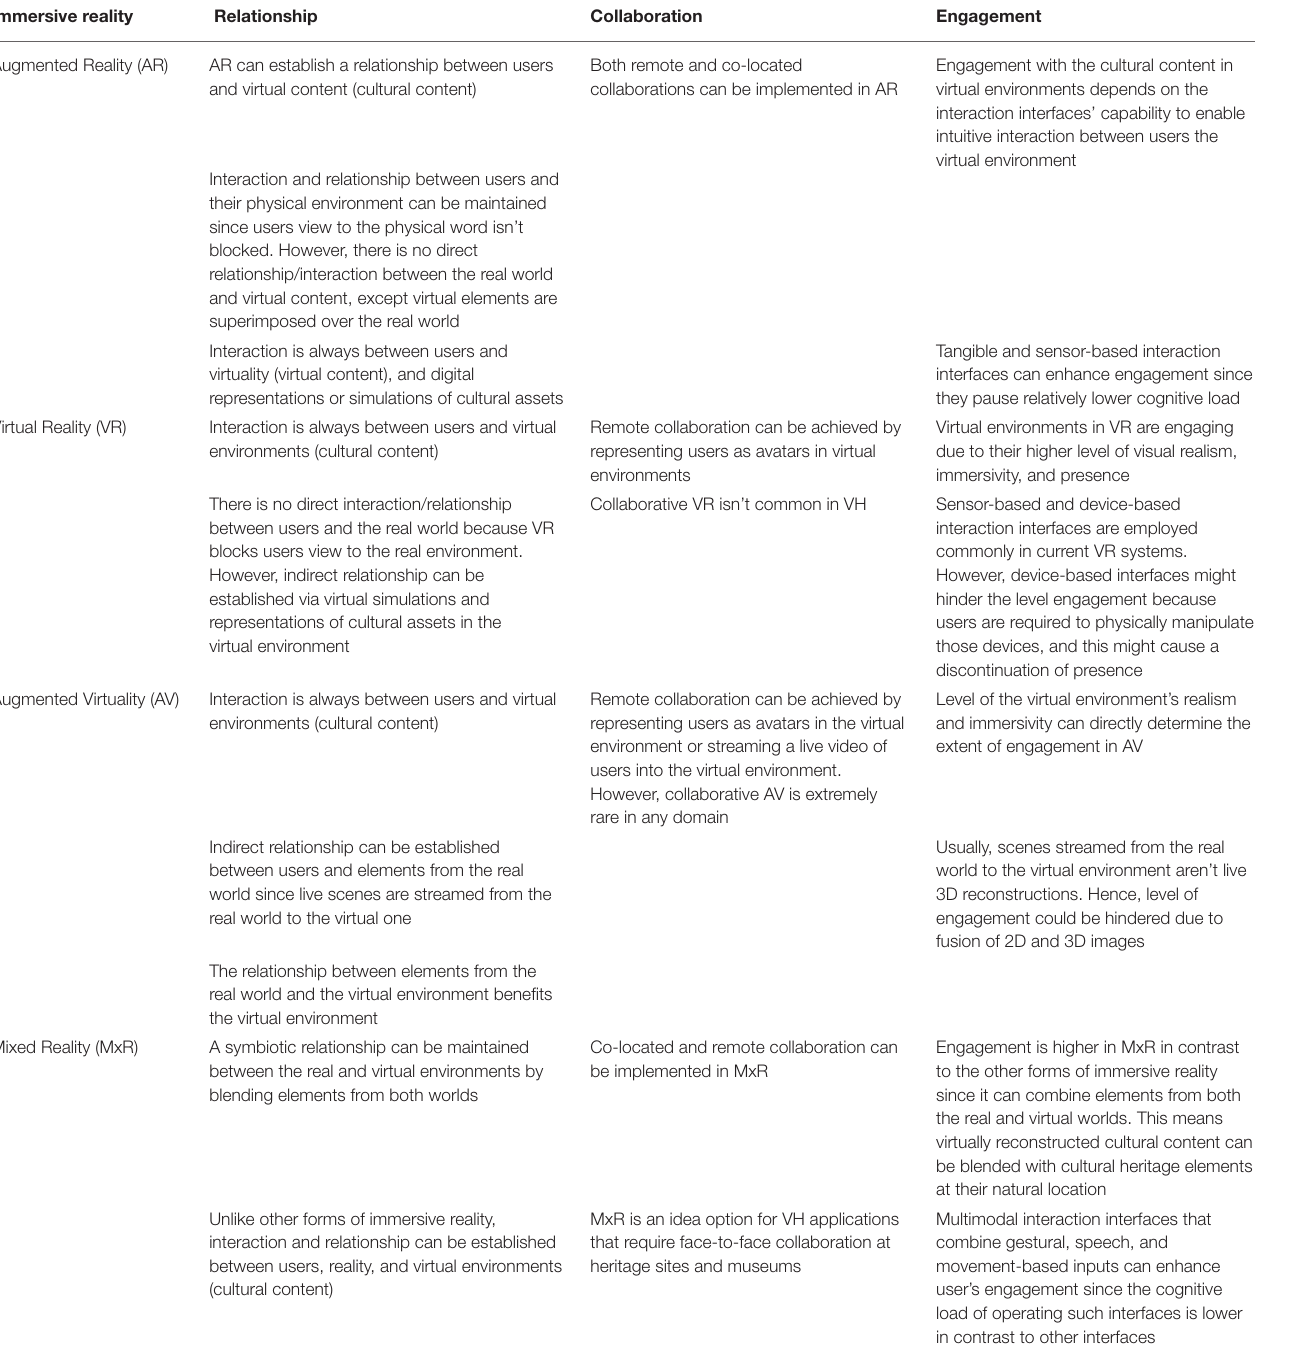
TABLE 3 | A comparison of different forms of immersive reality technology against relationship, collaboration, and engagement: the comparison assists predetermining the relevance of a given form of immersive reality to enable cultural learning in virtual heritage applications. Immersive